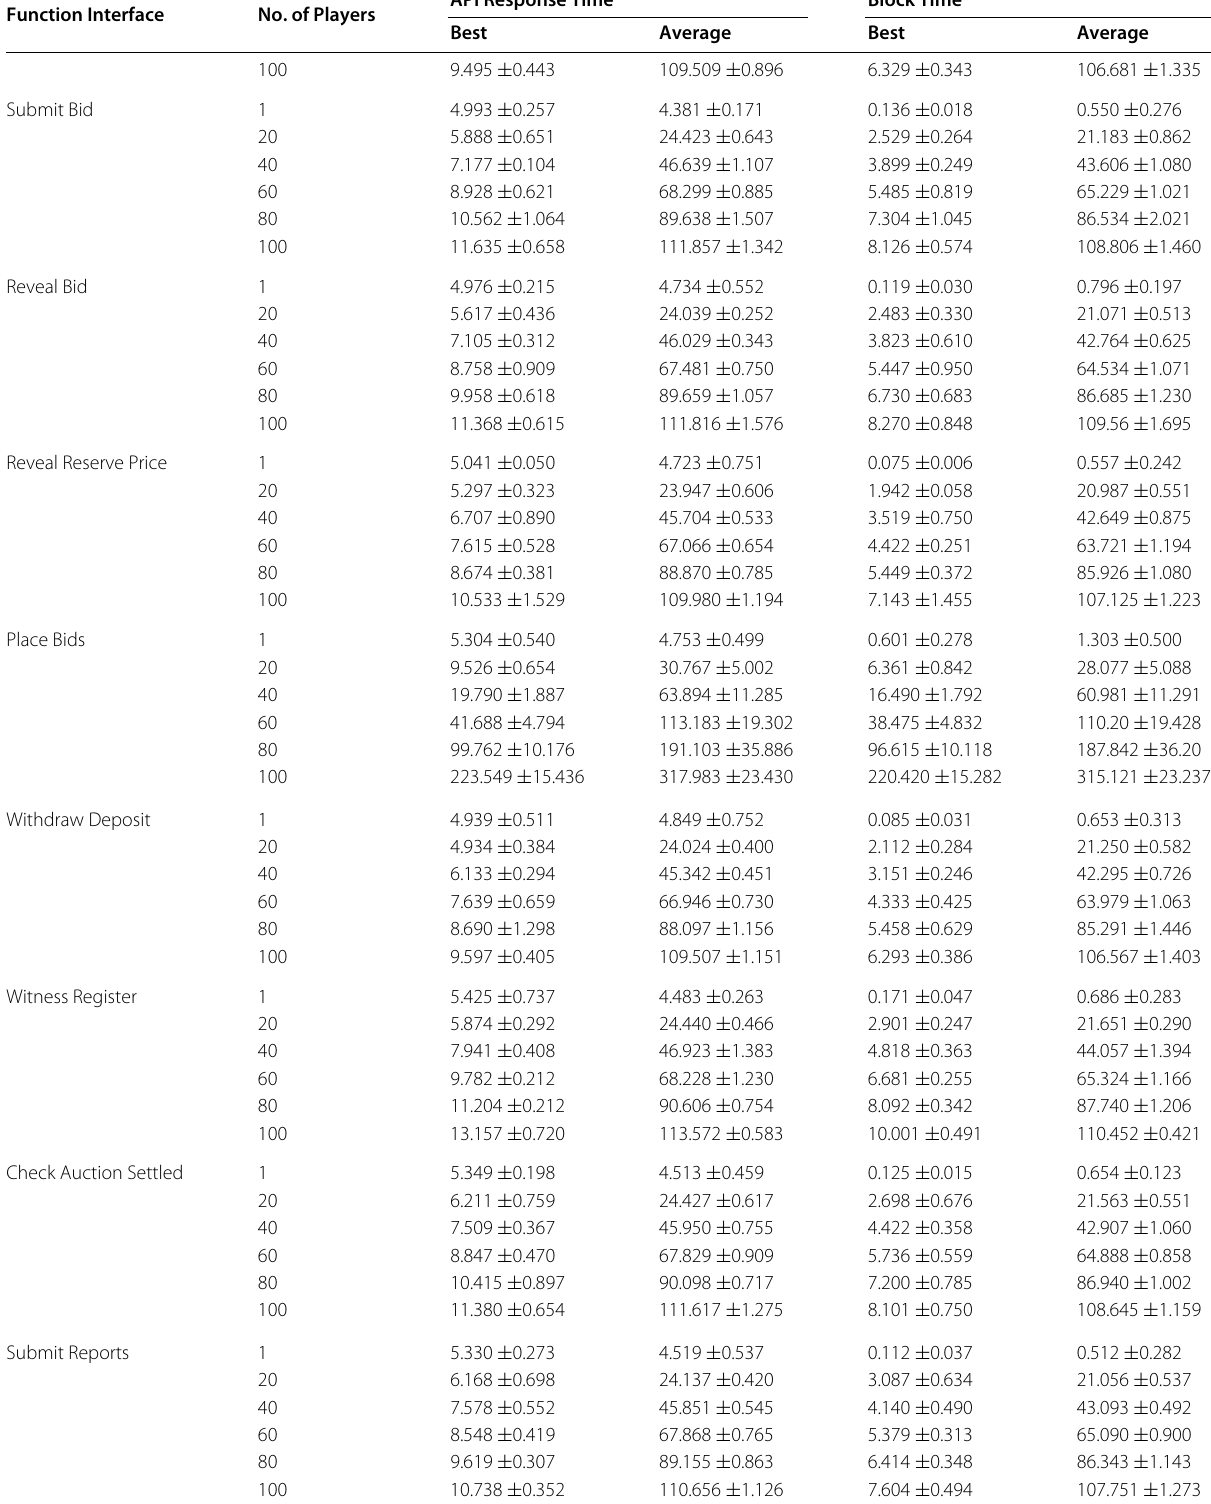
Table 1 Execution latency of the AWESOME contracts with different player numbers (s) ( Continued ) Function